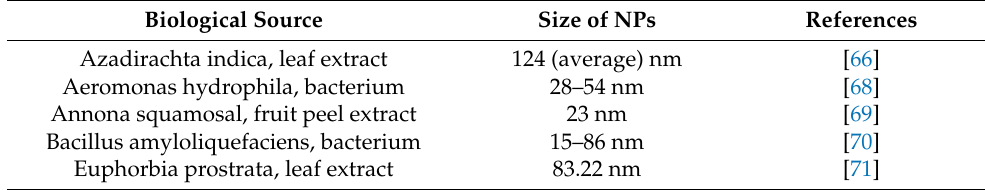
Table 1. Varying sizes of spherical TiO 2 NPs from different biological